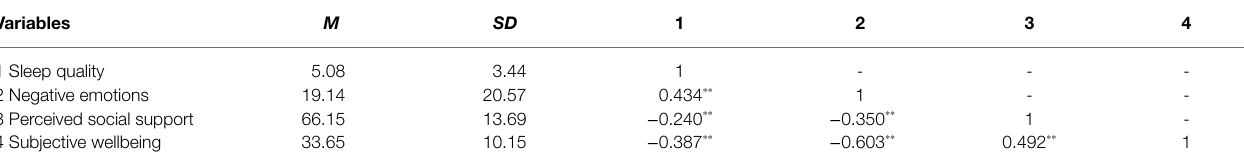
TABLE 1 | Results of descriptive statistics and correlation analysis for each variable ( n = 3,250). Variables